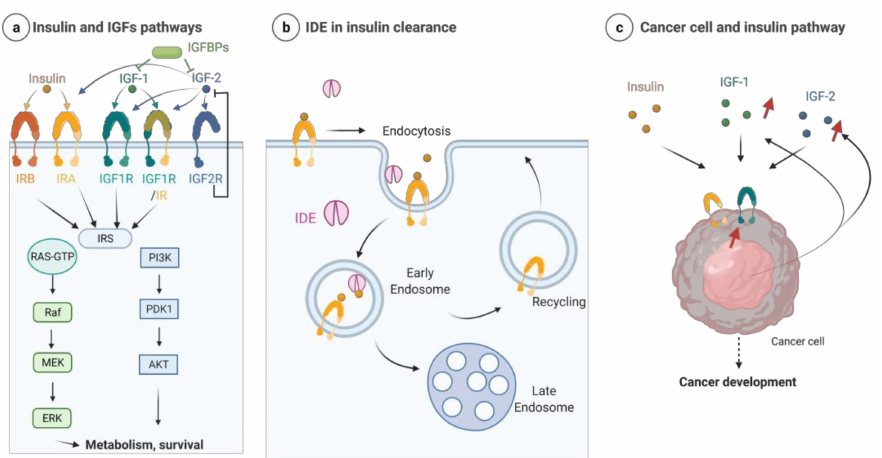
Figure 2. ( a ) Condensed representation of the insulin and IGF pathways. After ligand binding and activation, insulin and IGF1 receptors induce a signal through IRS via MAPK and AKT pathways to control cell metabolism and survival. IGFBP proteins bind IGFs and reduce their signals. The binding of IGF2 to IGF2-R leads to internalization and lysosomal degradation. ( b ) IDE is involved in insulin clearance, particularly in endosomes, after activating insulin receptors by its ligand. ( c ) Cancer cells overexpress insulin and IGF1 receptors. Cancer cells can produce IGF proteins that act in an autocrine and paracrine manner. Insulin and IGF pathways contribute to cancer development. Red arrows mean overexpression. Created with BioRender.com (accessed on 31 March 2022). IDE has been shown to play a significant role in the downstream signaling of